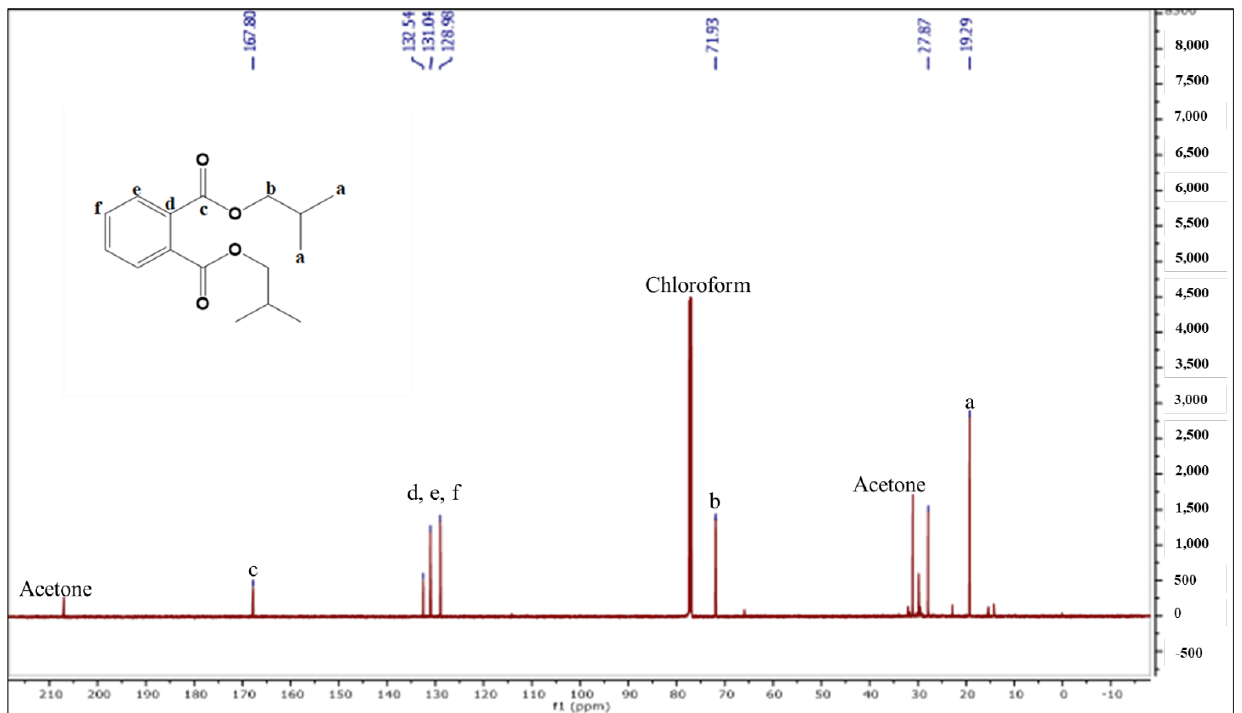
Figure 4. 13 C NMR of the BDCe fraction from Obea fraction of O. bracteata .